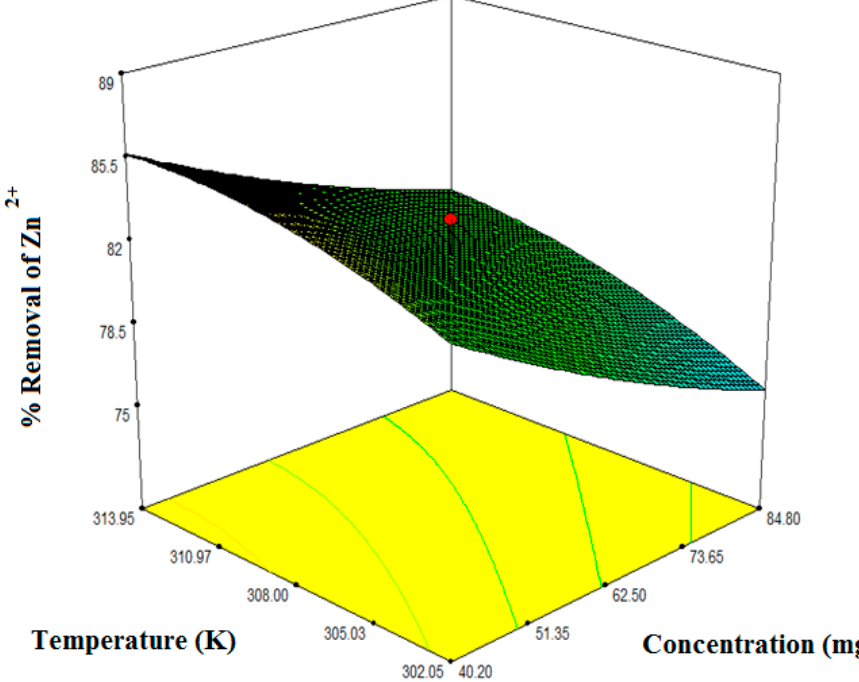
Figure 5. Interacting effects of metal ions concentration and adsorbent dose at temperature 308 K.